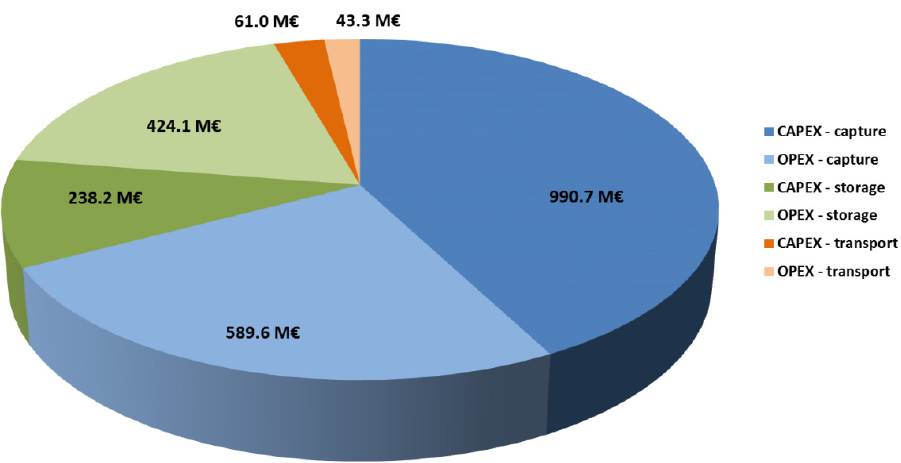
Figure 5. Graphical representation of CAPEX and OPEX of the analysed CCUS scenario.